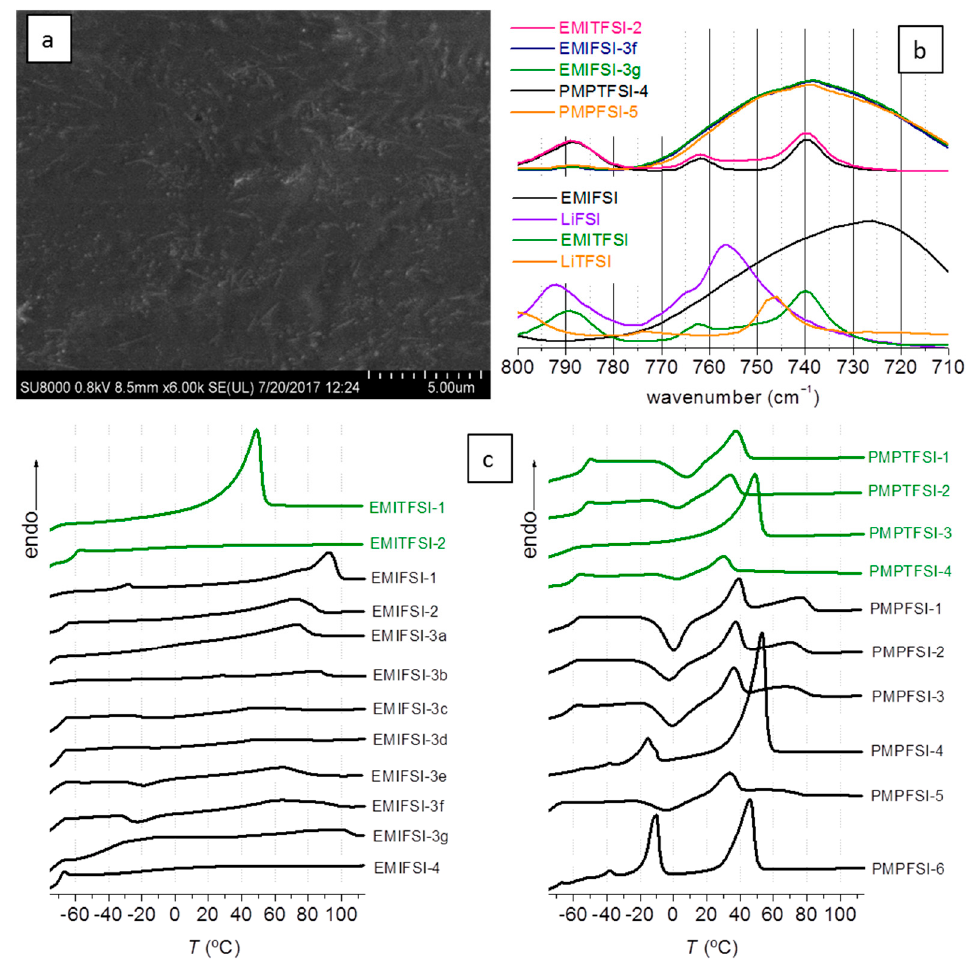
Figure 2. ( a ) EMIFSI-3c SEM image; ( b ) FTIR of some electrolytes (up) and RTIL and salts (down); and ( c ) DSC scans of a set of